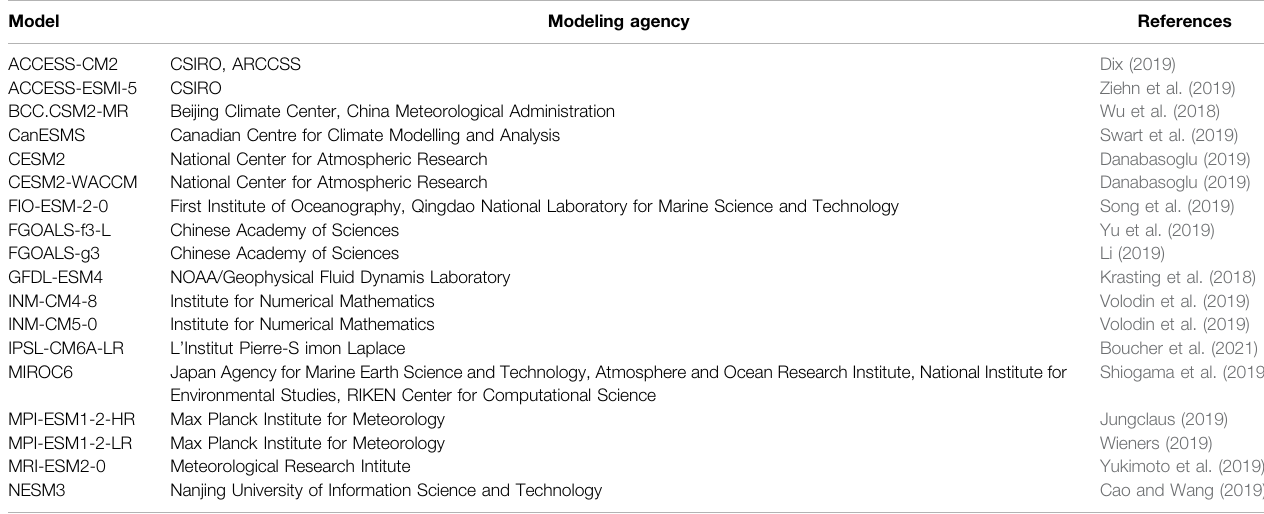
TABLE 1 | Summary of CMIP6 models used in this study.